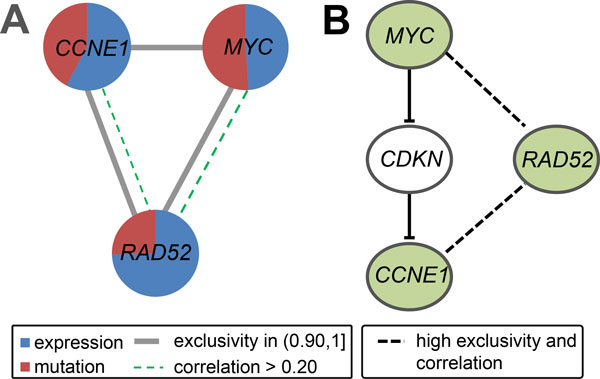
The first module identified by iMCMC in the ovarian carcinoma data and locations of the detected genes in known pathways. (A) All pairs of genes in this module are highly mutually exclusive with values more than 0.90. (B) The detected genes MYC and CCNE1 are in the cell cycle pathway. The dense dashed line represents pair of genes with exclusivity more than 0.90 and correlation larger than 0.20. RAD52 plays a central role in genetic recombination and DNA repair, and is not only highly exclusive but also correlated with MYC and CCNE1.